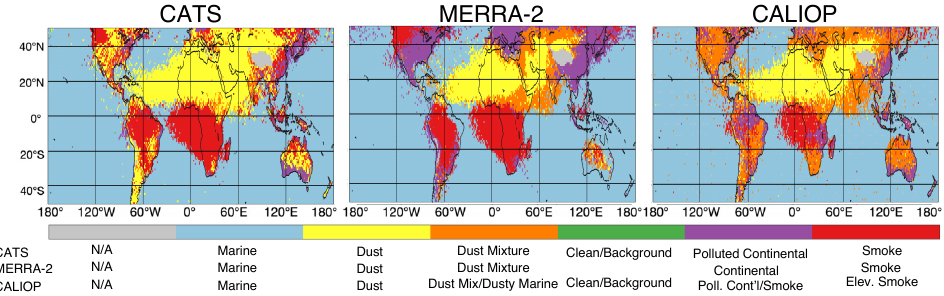
Figure 5. Comparison of the most frequently classified aerosol type below 4 km for CATS, MERRA-2, and CALIOP for JAS